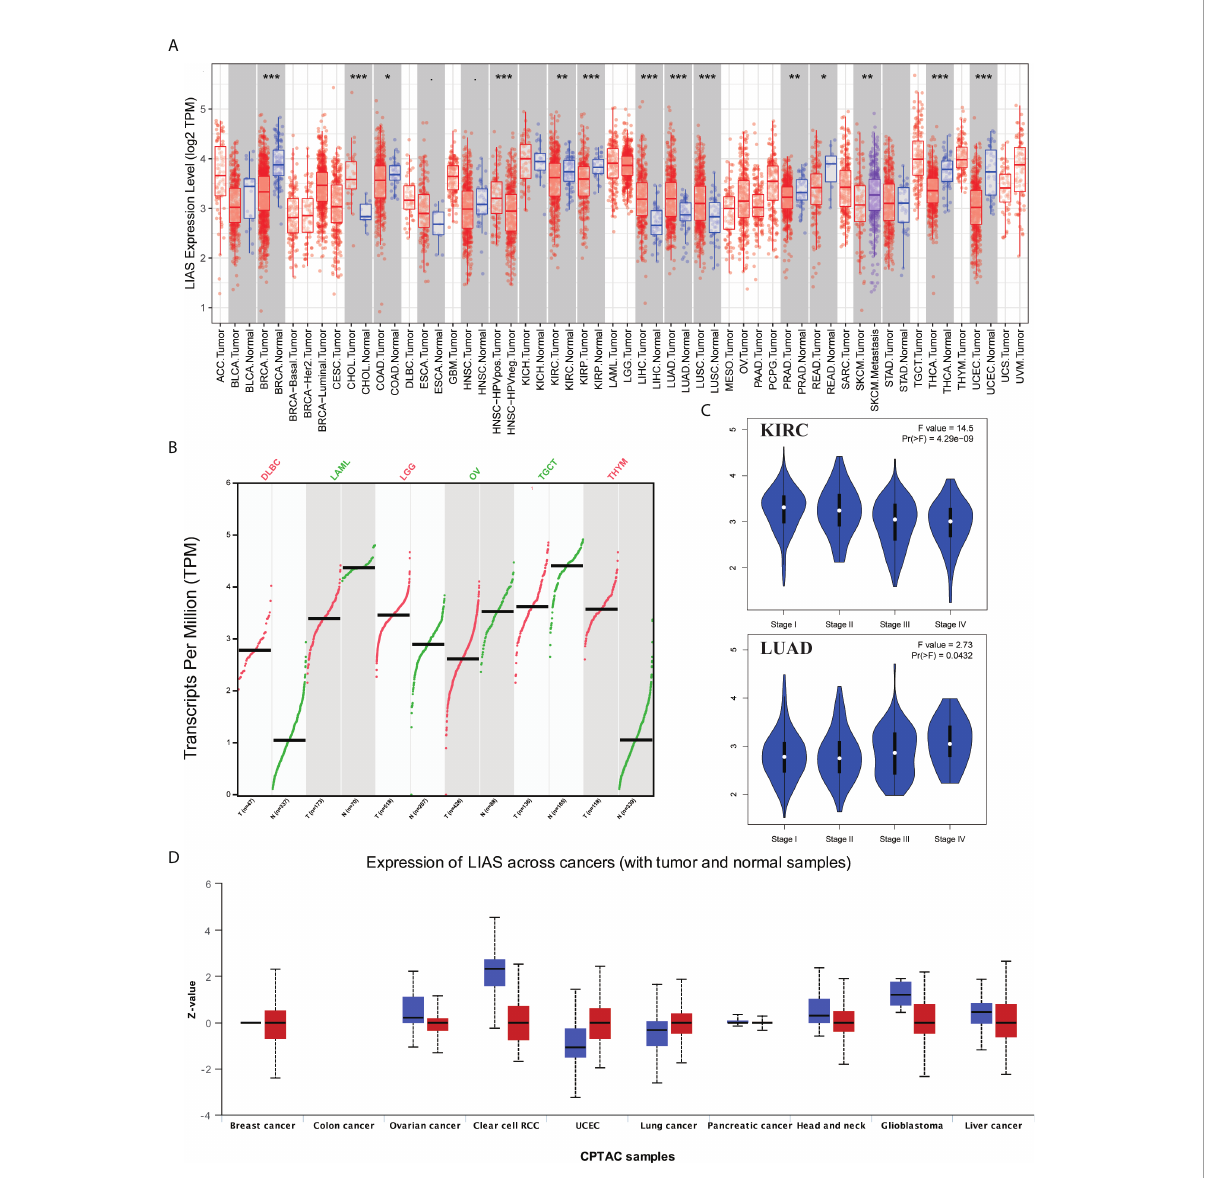
FIGURE 1 The expression levels of LIAS in pan-cancer. (A) TIMER2.0 showed the expression of LIAS across TCGA cancers and the corresponding normal tissues. ***p < 0.001; **p < 0.01; *p < 0.05. (B) GEPIA2.0 depicted the LIAS expression in the tumor group and normal group. (C) GEPIA2.0 showed the effect of LIAS on the pathological stages in KIRC and LUAD patients. (D) UALCAN website displayed the protein levels of LIAS in tumor and normal